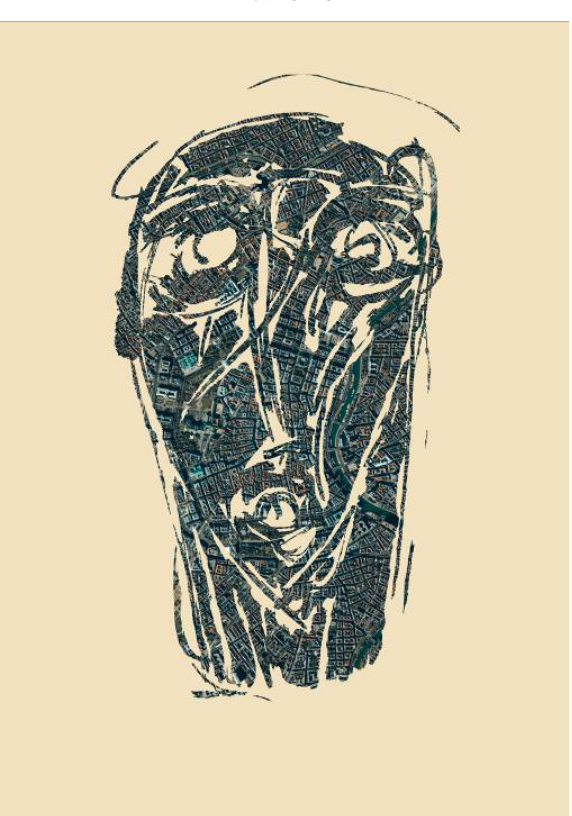
Figure 9 Tamer Assem – Vienna Man – Digital Print – 70x50cm –